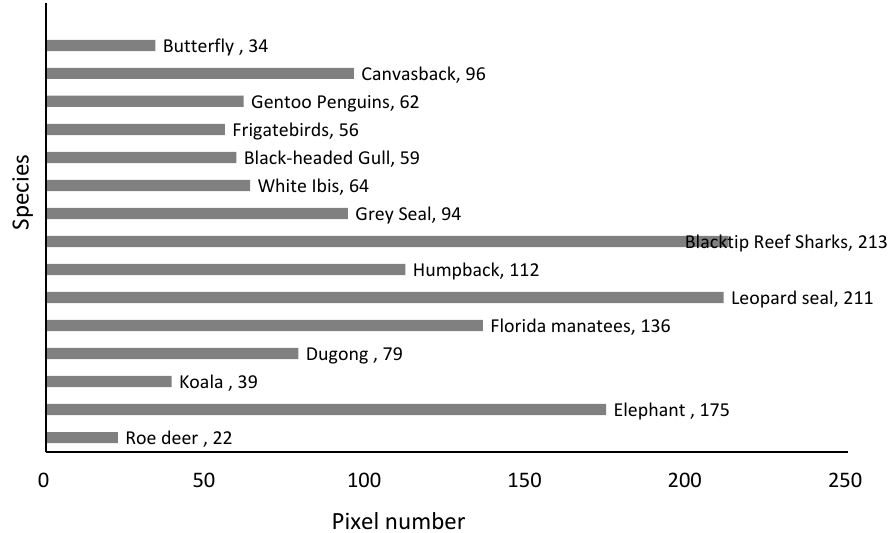
Figure 4. Pixel number of target species in UAS images. The pixel number, N , is estimated by N = Length / GSD , where Length represents the body length of the target adult animal and GSD represents the ground sample distance of the UAS images. The body lengths of the target adult animals were collected or estimated from the corresponding references.